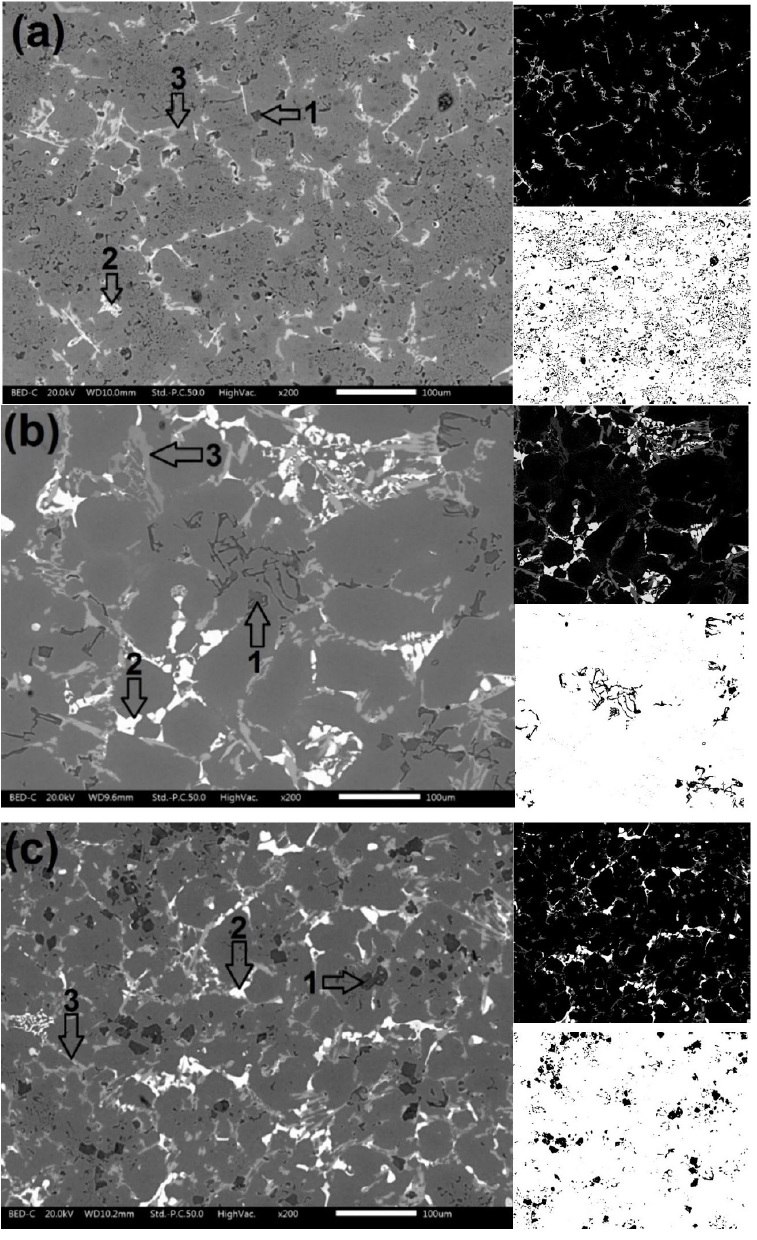
Figure 1. BE-SEM micrographs of the experimental alloys with Cu contents of: (a) 3%, (b) 5%, and (c) 7%. Arrows indicate visible second phases: (1)